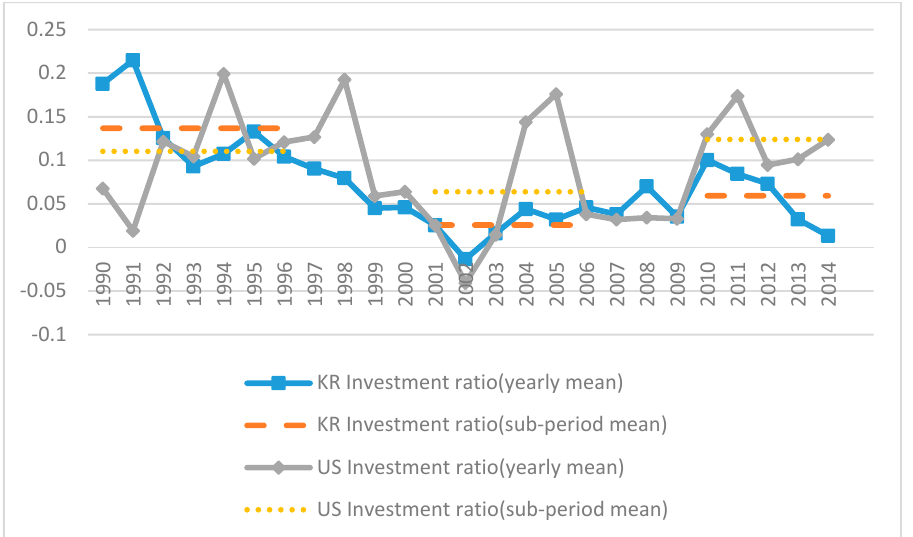
Figure 1. Comparison of investment ratio. Table 2. Comparison of investment ratio by regression.